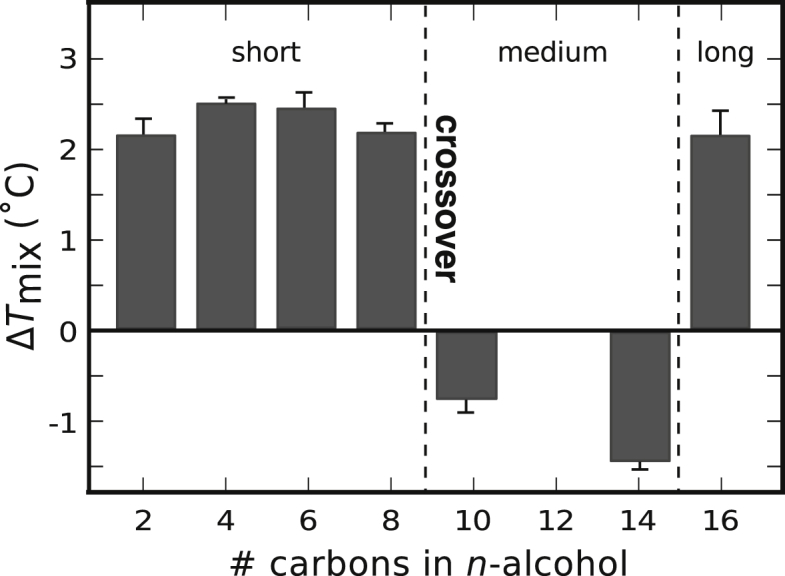
Increasing the number of carbons in n-alcohol solutions results in nonmonotonic shifts in Tmix for GUVs composed of 35/35/30 DOPC/DPPC/cholesterol. ΔTmix is with respect to GUVs in water. Concentrations of n-alcohol solutions correspond to three times the AC50 in (14). AC50 values for tetradecanol and hexadecanol were estimated at 5 μM. Each point represents a single experiment with uncertainties as in Fig. 1. Fig. S3 contains corresponding data at lower n-alcohol concentrations.